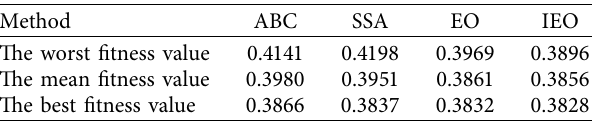
Figure 6: IEEE 33-bus radial distribution system. Table 3: Te comparison of ftness values found by four imple- mented methods for case